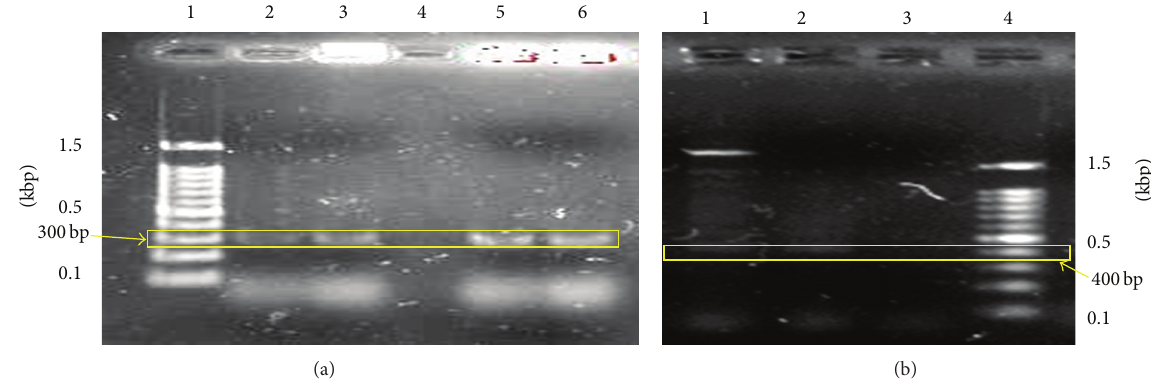
Figure 5: Molecular analysis of transgenesintegration in putative transgenic plantlets and control PLBs. (a) Single band of 300 bp which was produced on lanes 2 and 3 confirmed the transfer of wwin1 and wwin2 genes ( pr4 genes) into the PLBs (lane 1, marker; lane 2, putative transformant PLB (pW1B1); lane 3, putative transformant PLB (pW2KY); lane 4, untransformed PLB (control); Lane 5, A. tumefaciens (pW1B1); lane 6, A. tumefaciens (pW2KY)); (b) single band of 400 bp was produced on lanes 5 and 6 confirmed the transfer of nptII genes into the PLBs (lane 1, putative transformant PLB (pW1B1); lane 2, putative transformant PLB (pW2KY); lane 3, untransformed PLB (control); lane 4,